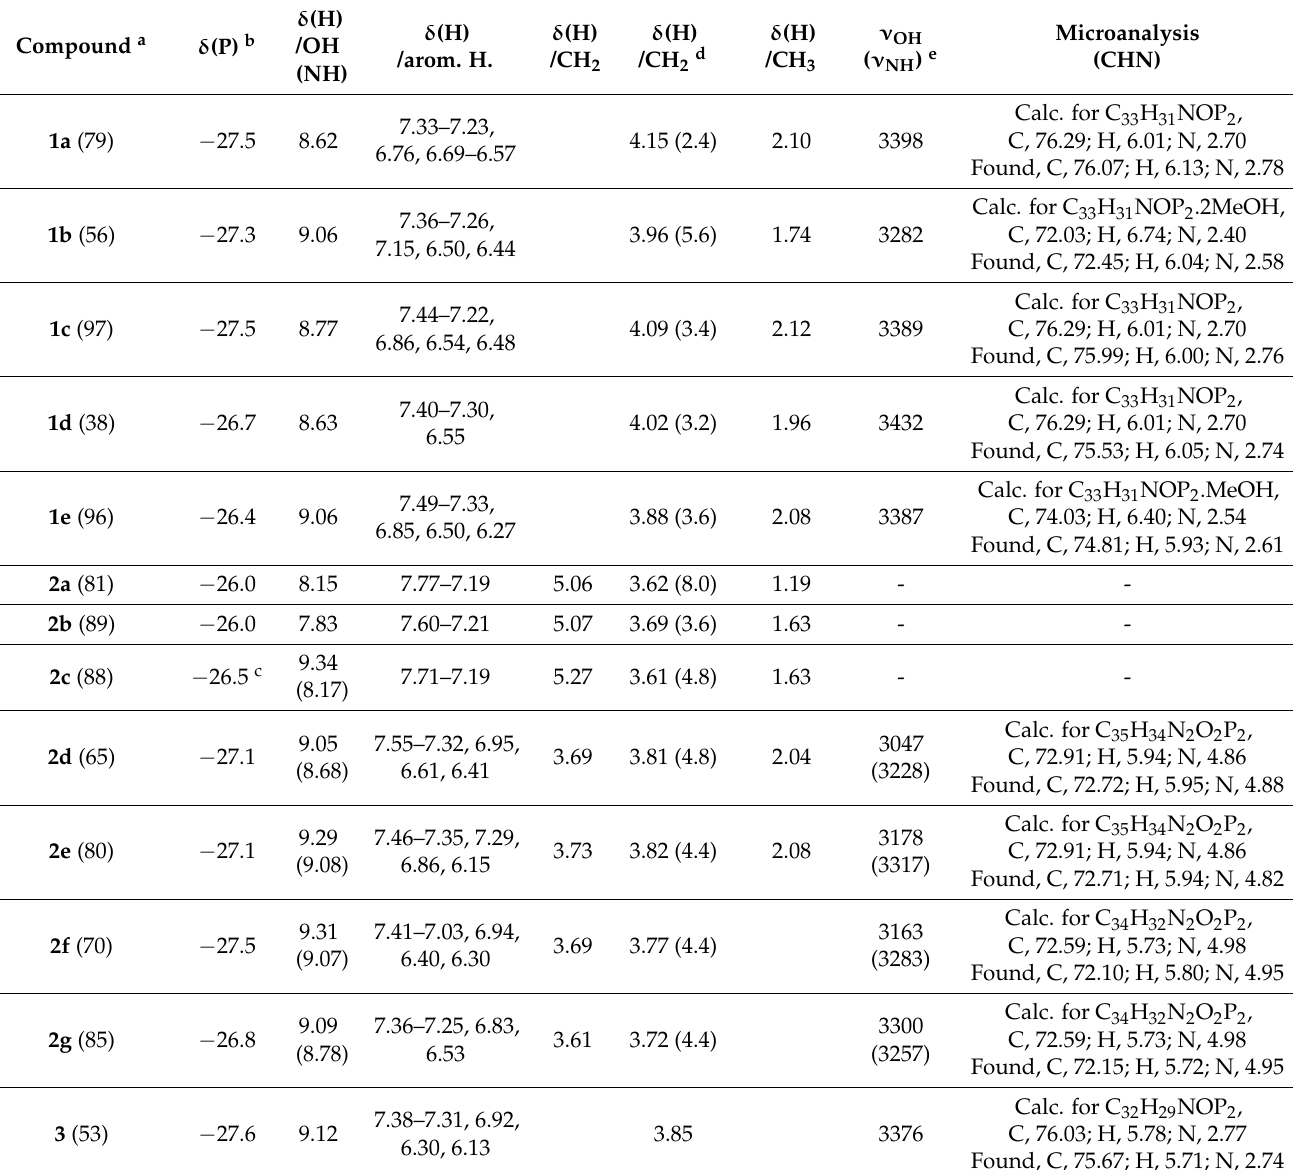
Table 1. Selected spectroscopic and analytical data for compounds 1a – 3 a